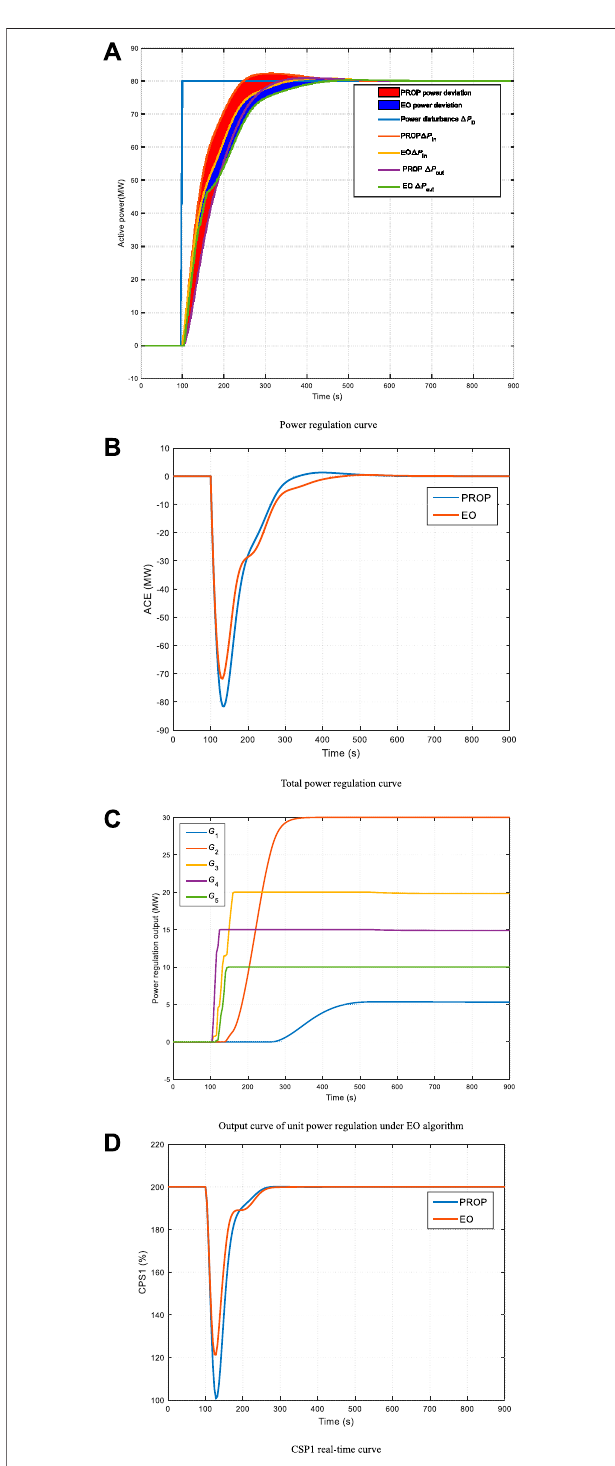
FIGURE 4 | Result of optimization when △ PL = 80 MW. ACE: area control error; CPS: control performance